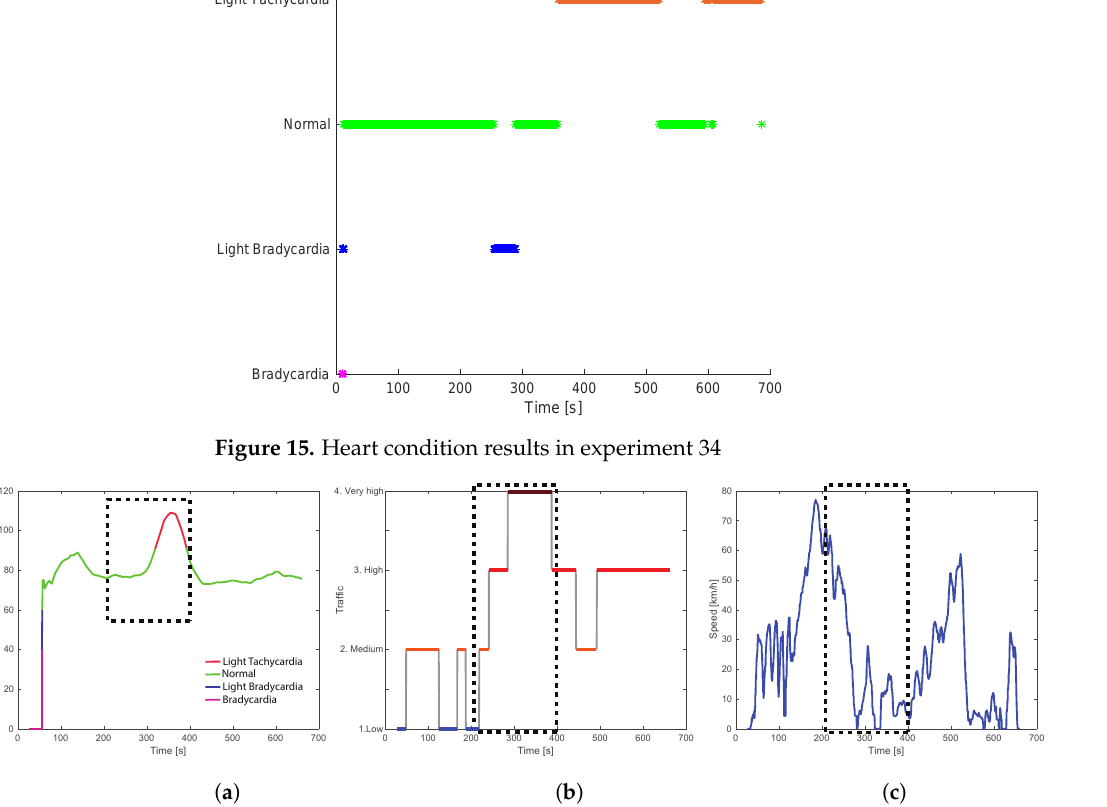
Figure 16. Light tachycardia analysis—experiment 7. ( a ) Heart rate, ( b ) traffic and ( c ) vehicle speed. Each plot is marked with the time when the event that increased the driver’s heart rate